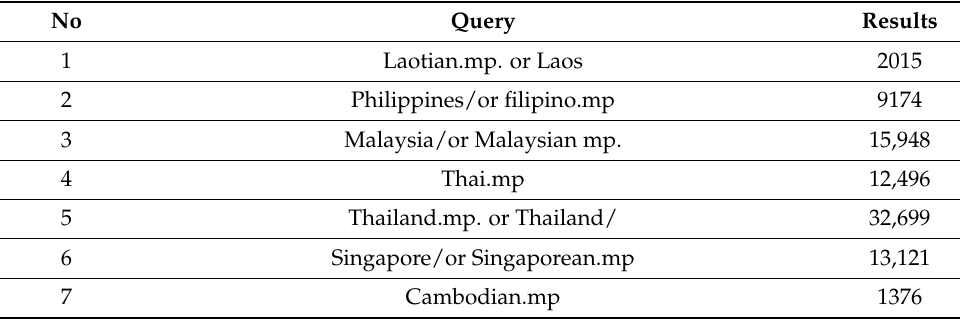
Table 1. Sample search using the Ovid Medline